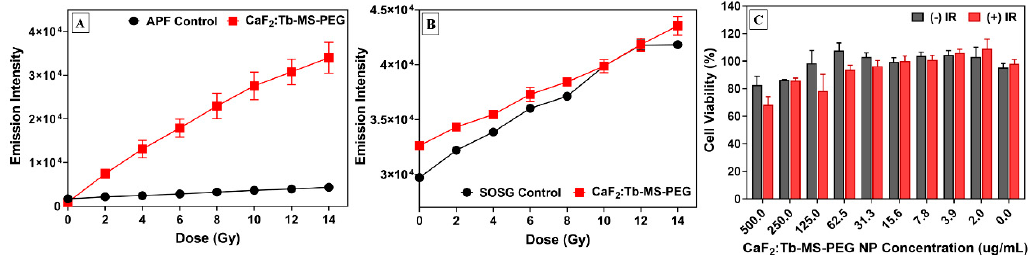
Figure 6. Assessment of CaF 2 :Tb-MS-PEG NPs for XRT. Fluorescent sensor XRT enhancement assays as a function of radiation dose for ( A ) hydroxyl radical using detection of aminophenyl fluorescein (APF) fluorescence intensity and ( B ) singlet oxygen using detection of Singlet Oxygen Sensor Green (SOSG) fluorescence intensity, with and without CaF 2 :Tb-MS-PEG NPs (125 µg/mL). In vitro cell viability assay ( C ) evaluating synergetic effects of XRT (4 Gy) and CaF 2 :Tb-MS-PEG NPs (0 to 500 µg/mL) on CT26 colorectal cancer cells; (+)-IR = with irradiation, (-)-IR = without irradiation.